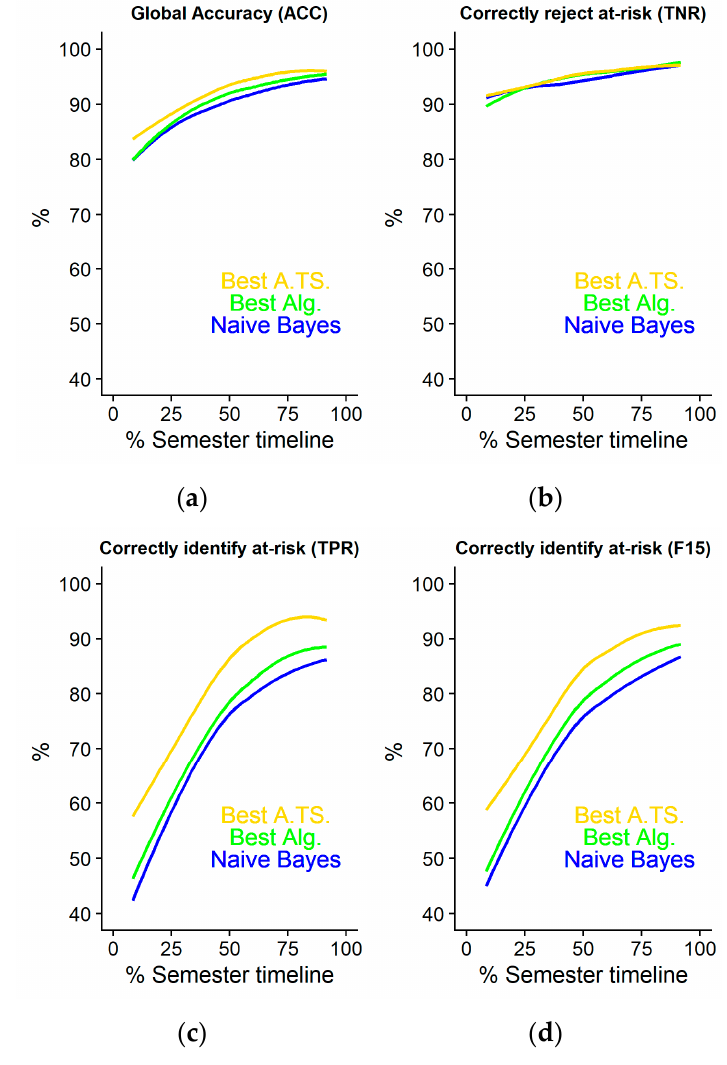
Figure 3. LOESS regression plots of the GAR model using Naive Bayes Classifier, selecting best algorithm (Best Alg.) and selecting best algorithm and training set (Best A. TS.) for ( a ) Accuracy, ( b ) TNR, ( c ) TPR, and ( d ) F-score F 1,5 metrics for 20182 semester. Table 3. Distribution of the classification algorithm selection for 2019 spring semester.